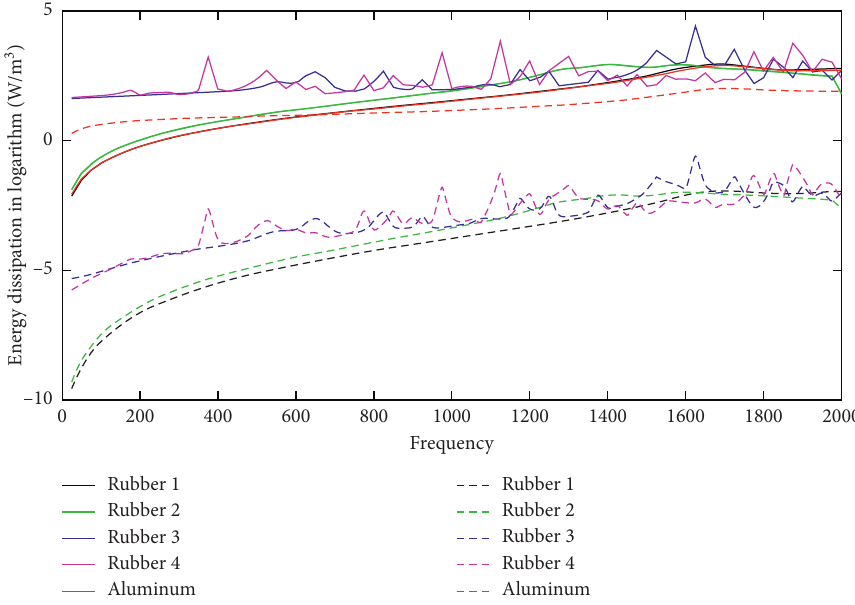
Figure 8: The thermal (dashed line) and viscous energy dissipation of five materials.